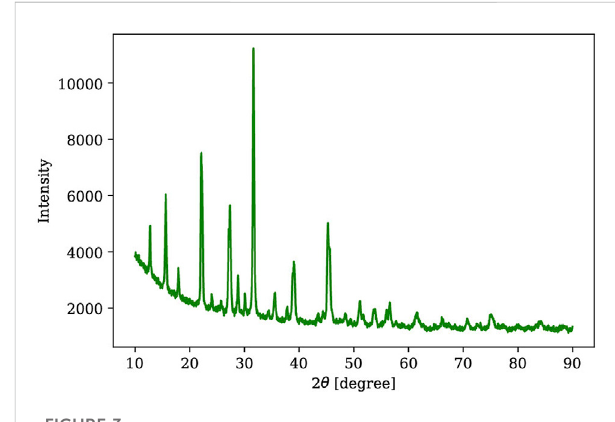
FIGURE 3 PXRD pattern of gel-grown of Cs 3 Bi 2 Br 9 single crystal.